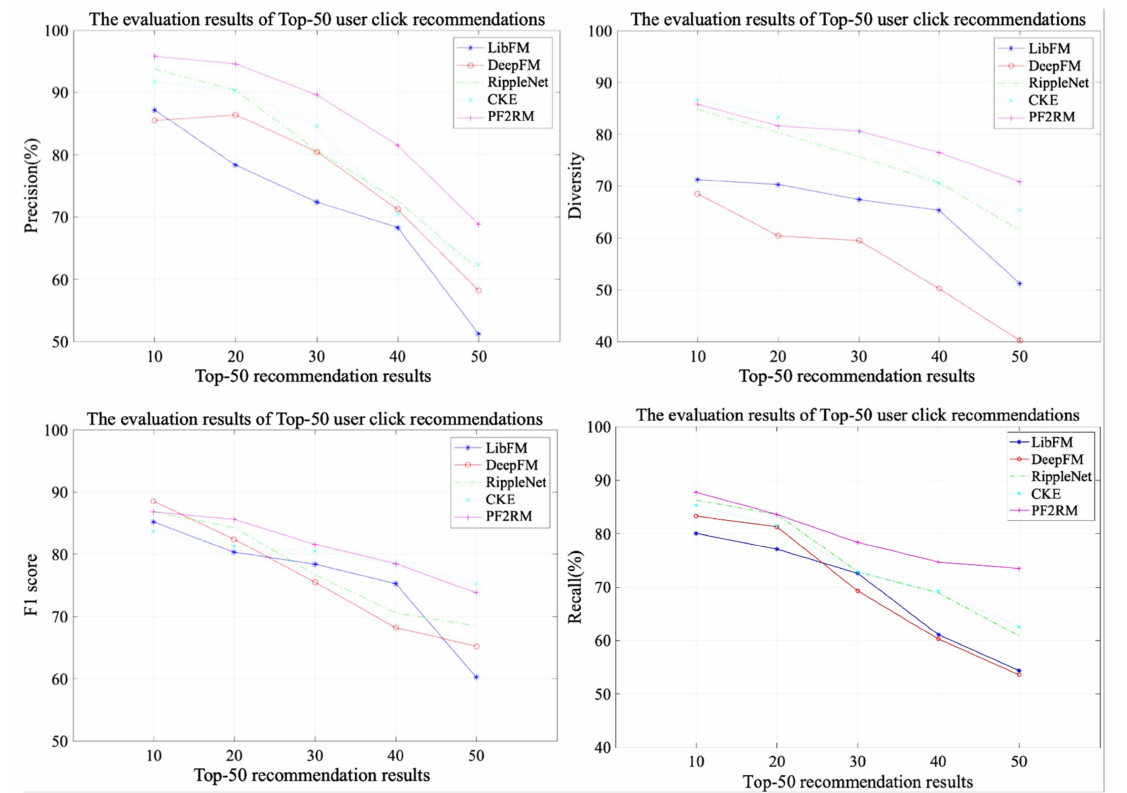
Figure 9. Three evaluation results of Top-50 user click